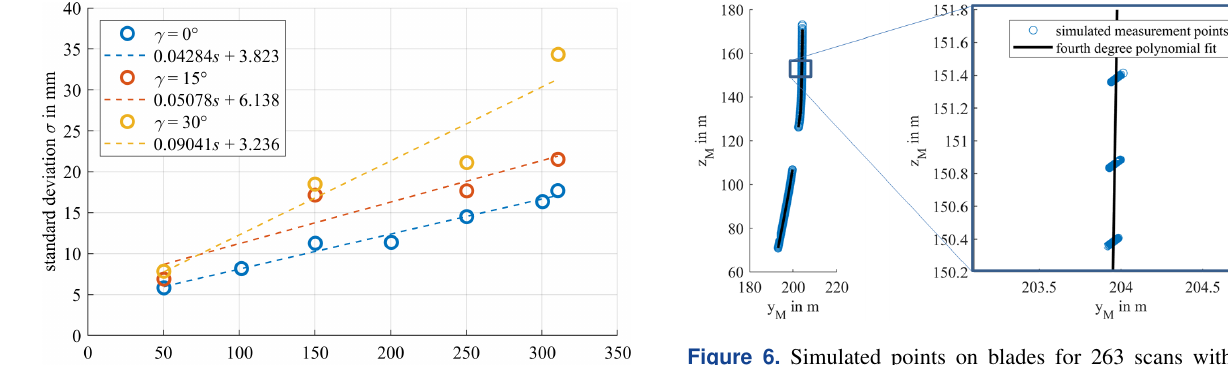
fects from the blades’ movement into account. Through all simulated measuring points (92 × 263 for the upper blade and 83 × 263 for the lower blade), a fourth-degree polyno- mial function is fitted through the points, separately for the upper and the lower blade (black lines in Fig. 6), as described in the method in Sect. 2.2.2.